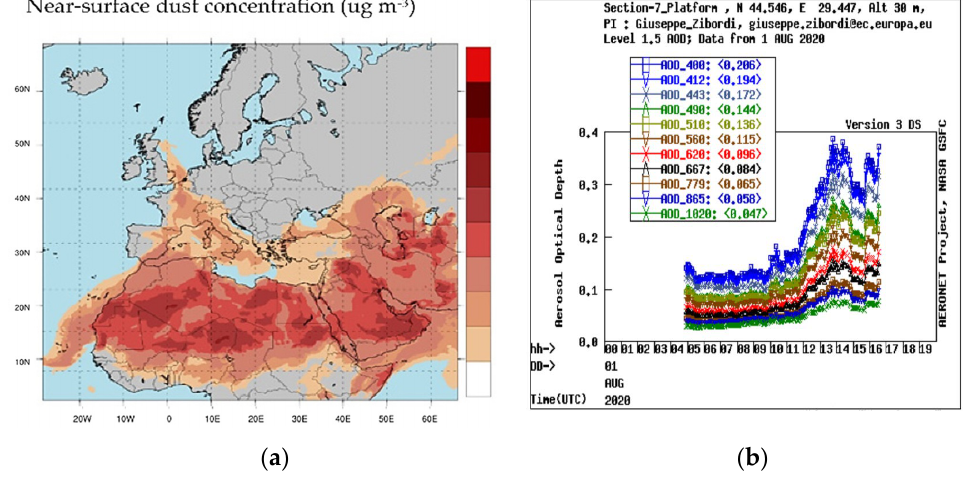
Figure 3. WRF dust load forecast for 01.08.2020 ( a ) and the corresponding dynamics of the change in the AOT (01.08.2020 ( b )).